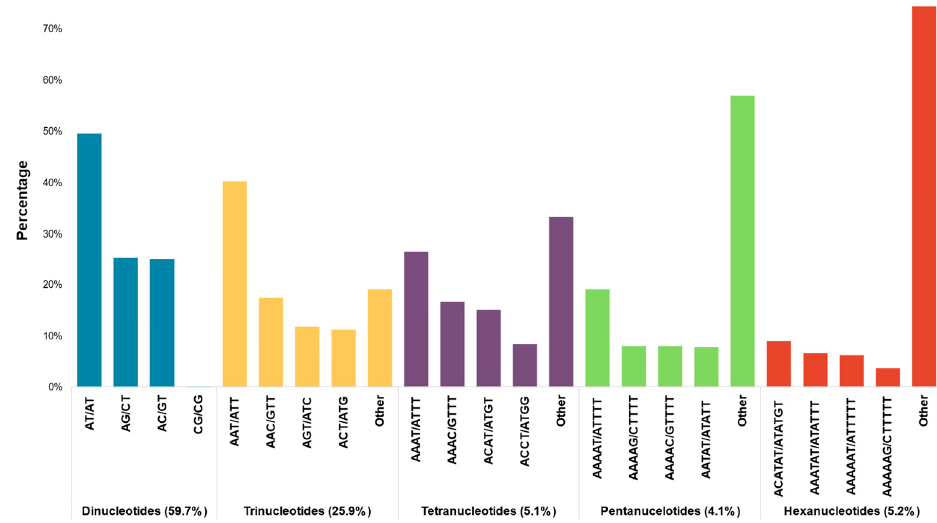
Figure 1. Frequency of SSR repeat motifs in T. cinerariifolium assembly.